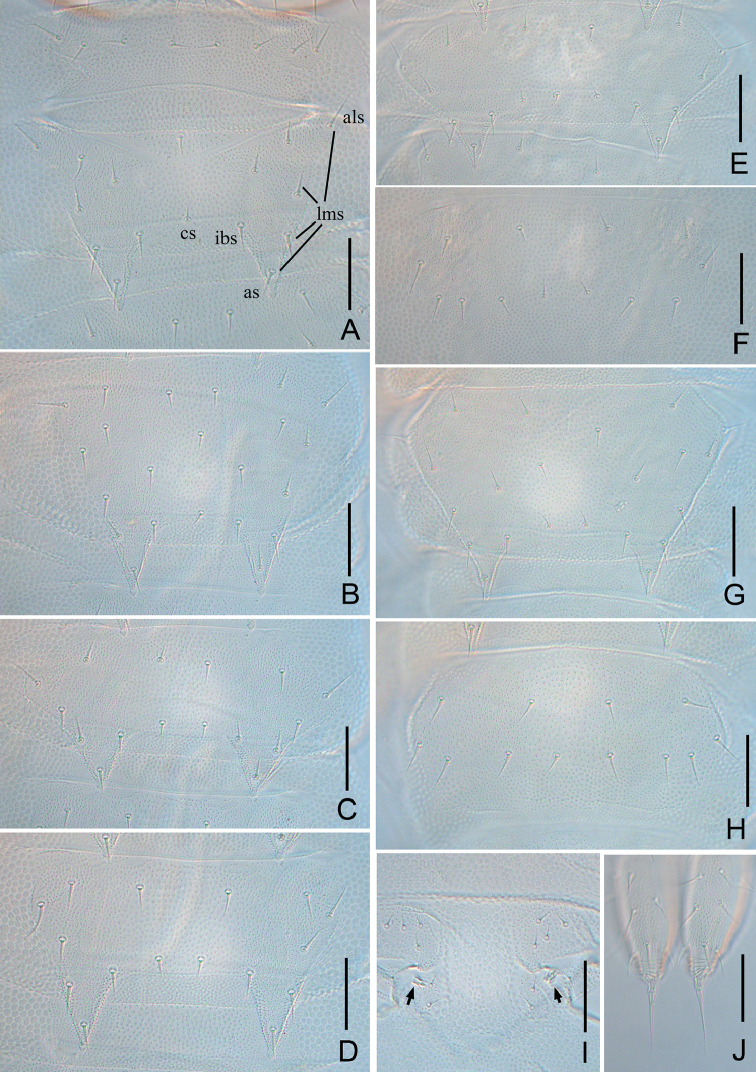
Symphylella
minuta sp. nov. A 1st and 2nd tergites (als-anterolateral seta, as-apical seta, cs-central seta, ibs-inner basal seta, lms-lateromarginal seta) B 3rd tergite C 4th tergite D 5th tergite E 13th tergite F 14th tergite G 15th tergite H 16th tergite I styli and base of 4th leg (arrows indicate styli) J cerci, dorsal view. Scale bars: 20 μm.